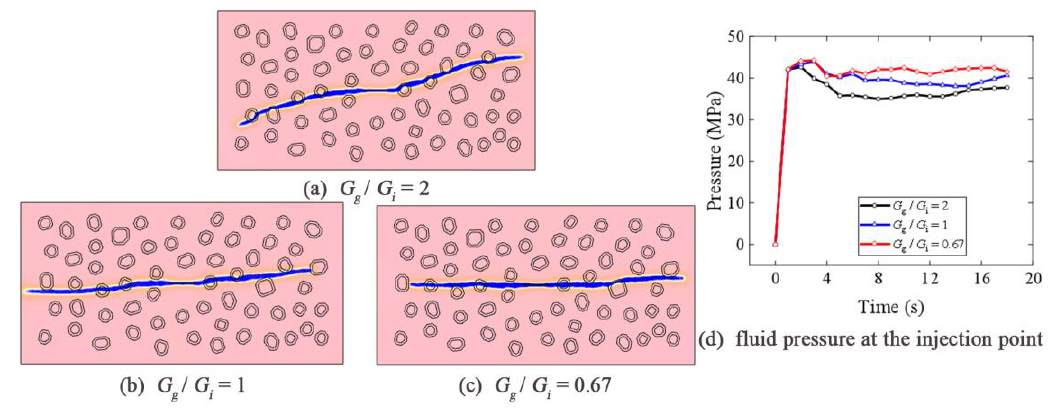
Figure 10. Fracture propagation and fluid pressure at the injection point for various G g / G i .